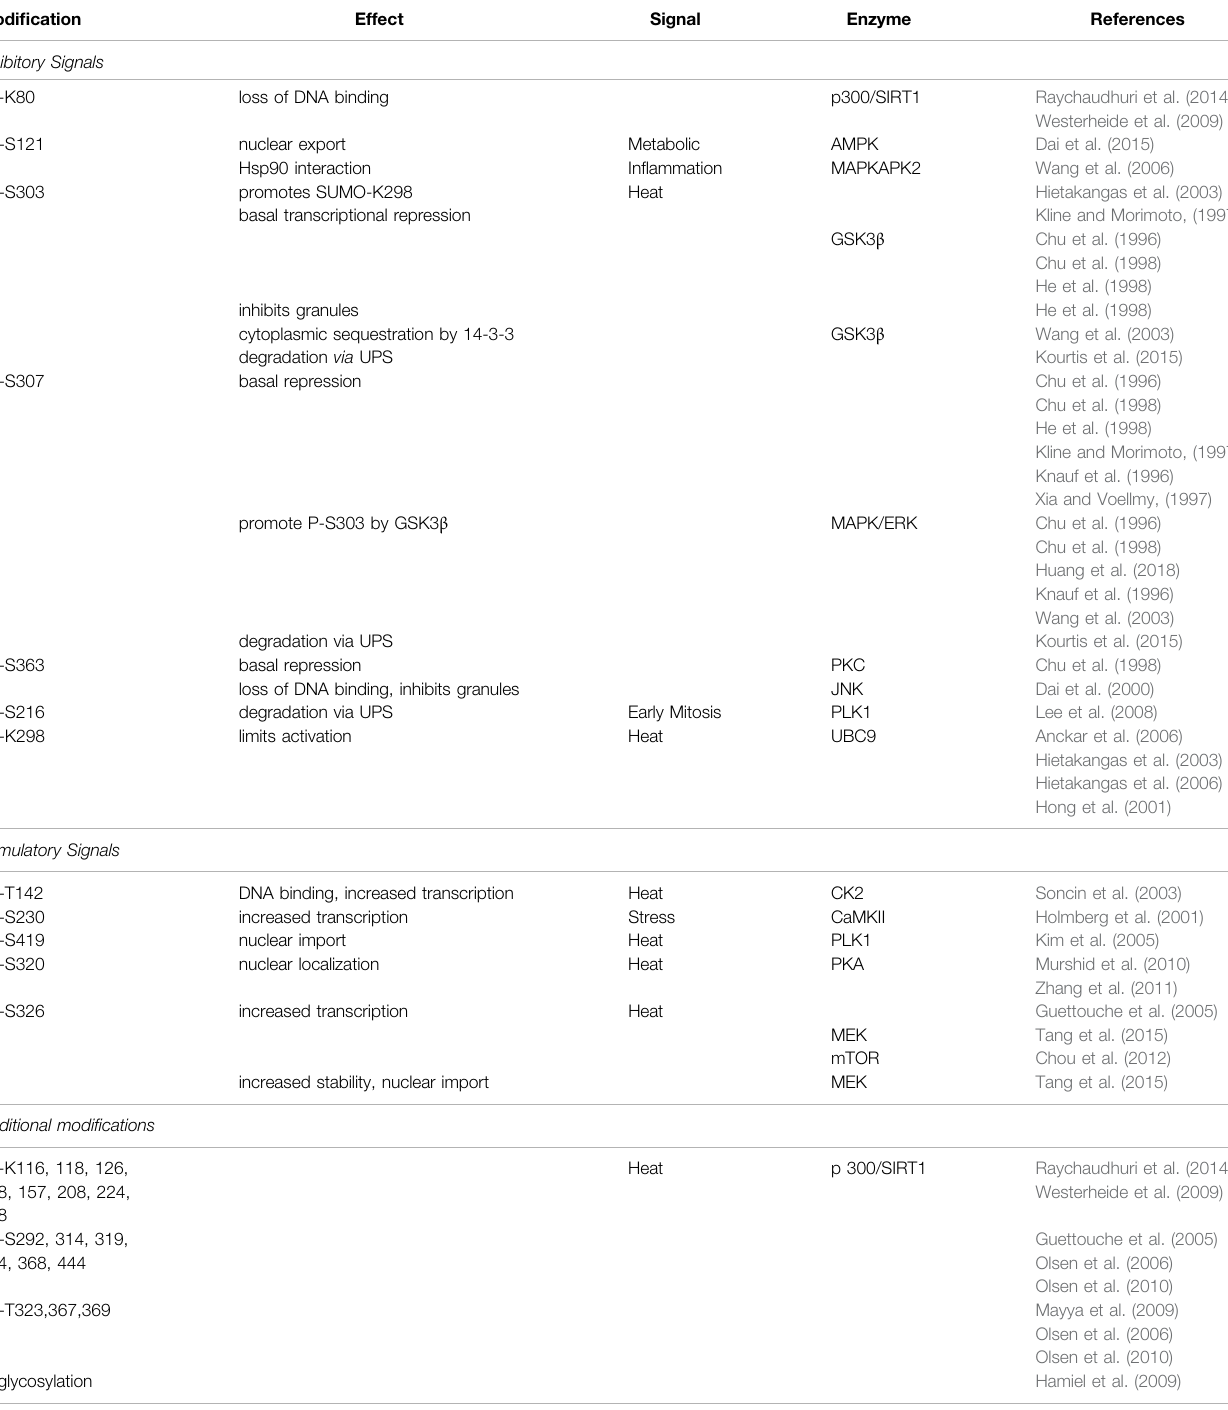
TABLE 1 | HSF1 post-translational modi fi